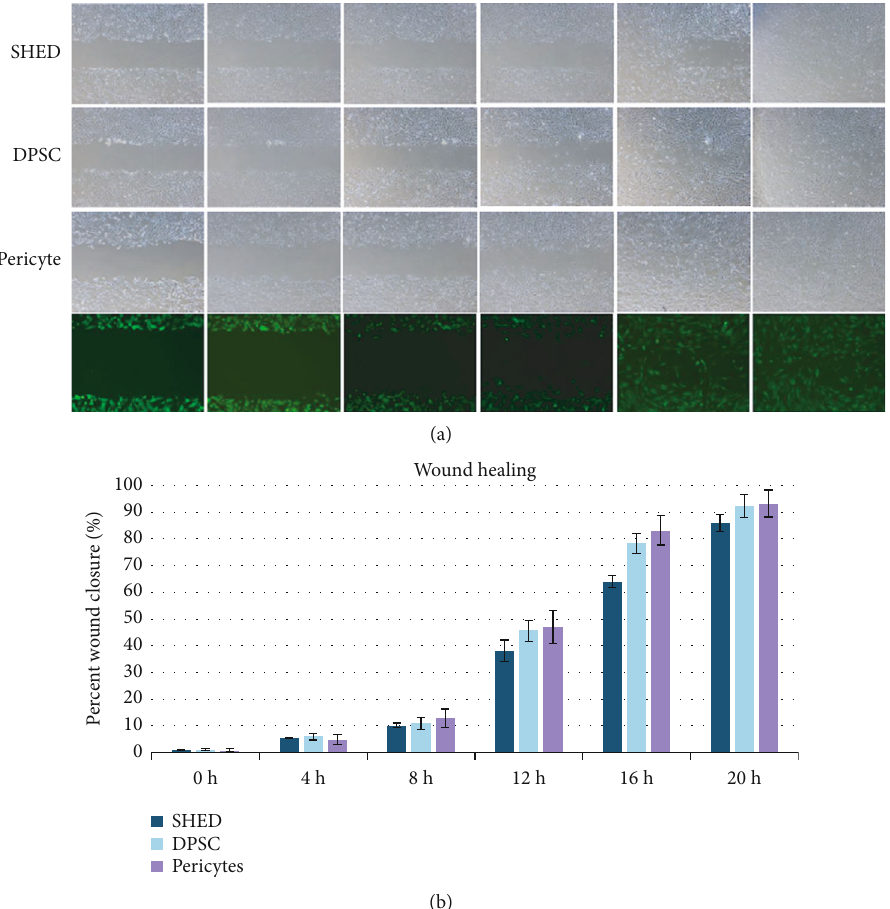
Figure 4: Migration potential of stem cells from human exfoliated deciduous teeth (SHEDs), postnatal human dental pulp stem cells (DPSCs), and pericytes via a wound-healing assay. (a) Phase-contrast images. (b) Percent wound closure